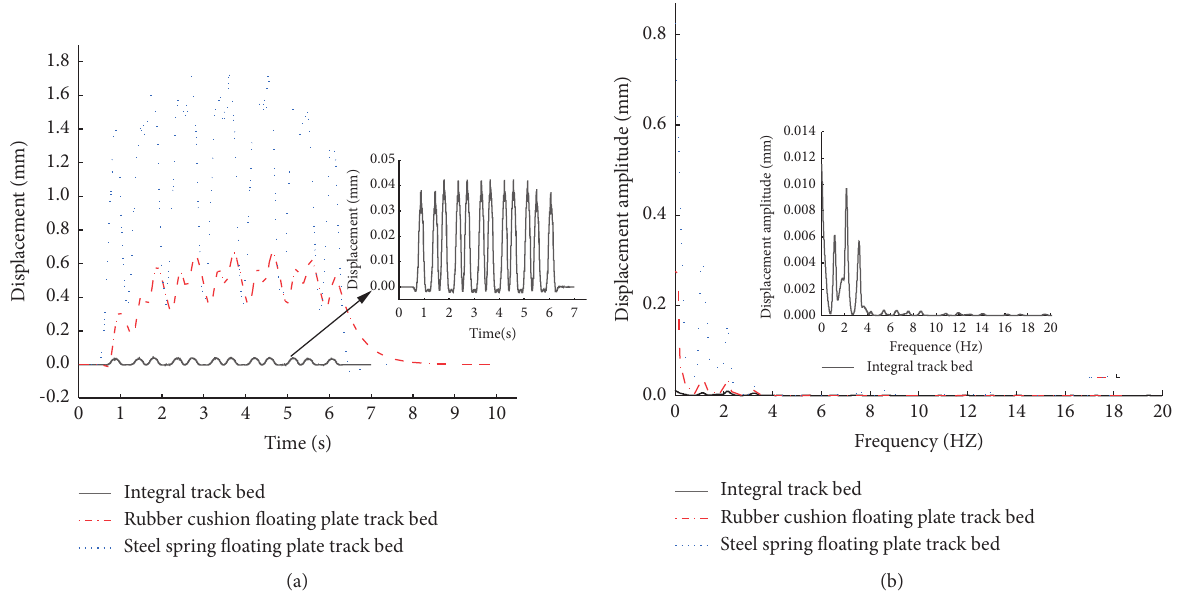
Figure 12: (a) Time-history and (b) frequency-history curves of vertical displacement of left monitoring point under different trackbed forms.